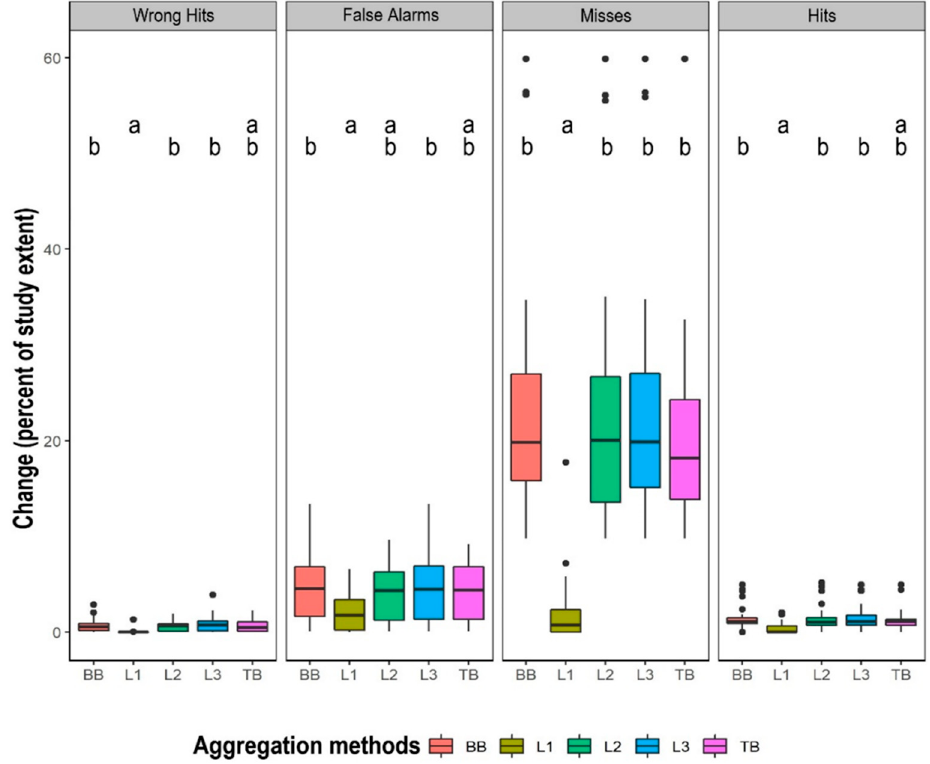
Figure 7. Figure of Merit (FOM) components expressed as a percent of the study area, grouped by aggregation method, where Wrong Hits = area of observed change predicted as change to the wrong category, False Alarms = area of observed persistence predicted as change, Misses = area of observed change predicted as persistence, Hits = area of observed change predicted as change to the correct category. The groups that are not significantly different are assigned a common letter. BB, L1, L2, L3 and TB groups include 24,24,24,24 and 18 model runs, respectively. The vertical middle line shows the median, the box boundaries show the first and third quartiles of the group, the lower and upper end of whiskers show the group’s minimum and maximum values that are not outliers, while the points show the outliers.